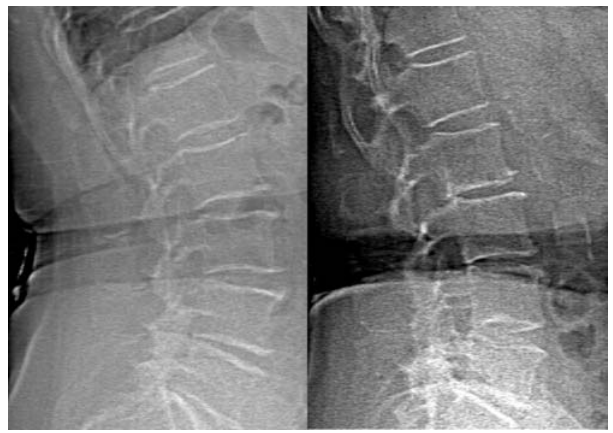
Figure 1. Examples of VFA Images with Inadequate Space (Left Panel) and Adequate Space (Right Panel) Anterior to the Aorta for AAC Assessment.